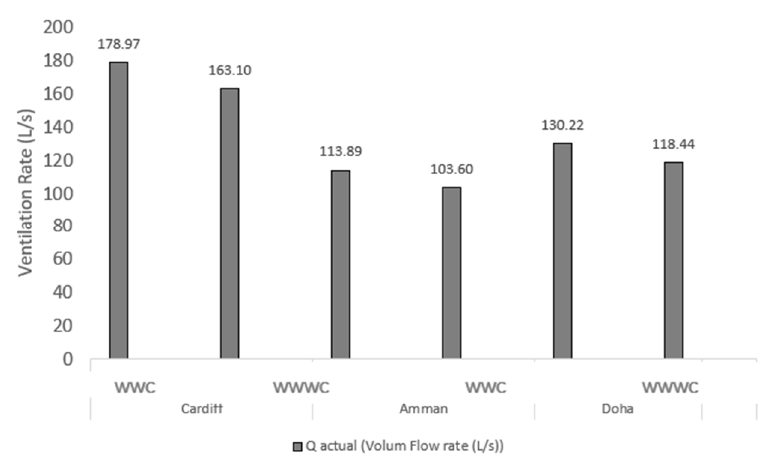
Figure 19. Actual ventilation rate using a Window-WindCatcher (WWC) and Without Window- WindCatcher (WWWC).